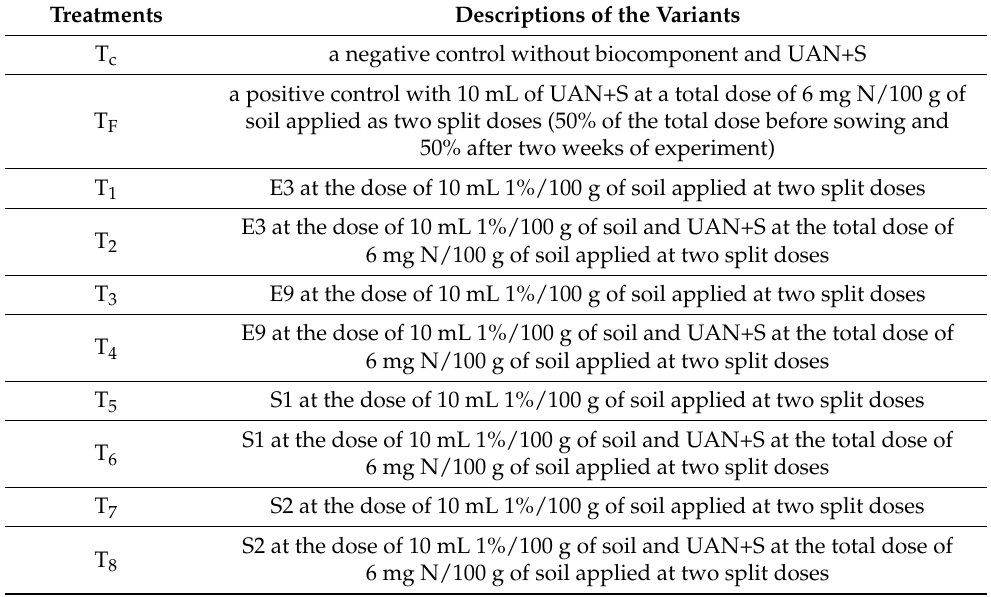
Table 2. Descriptions of the fertilizer treatments in pot